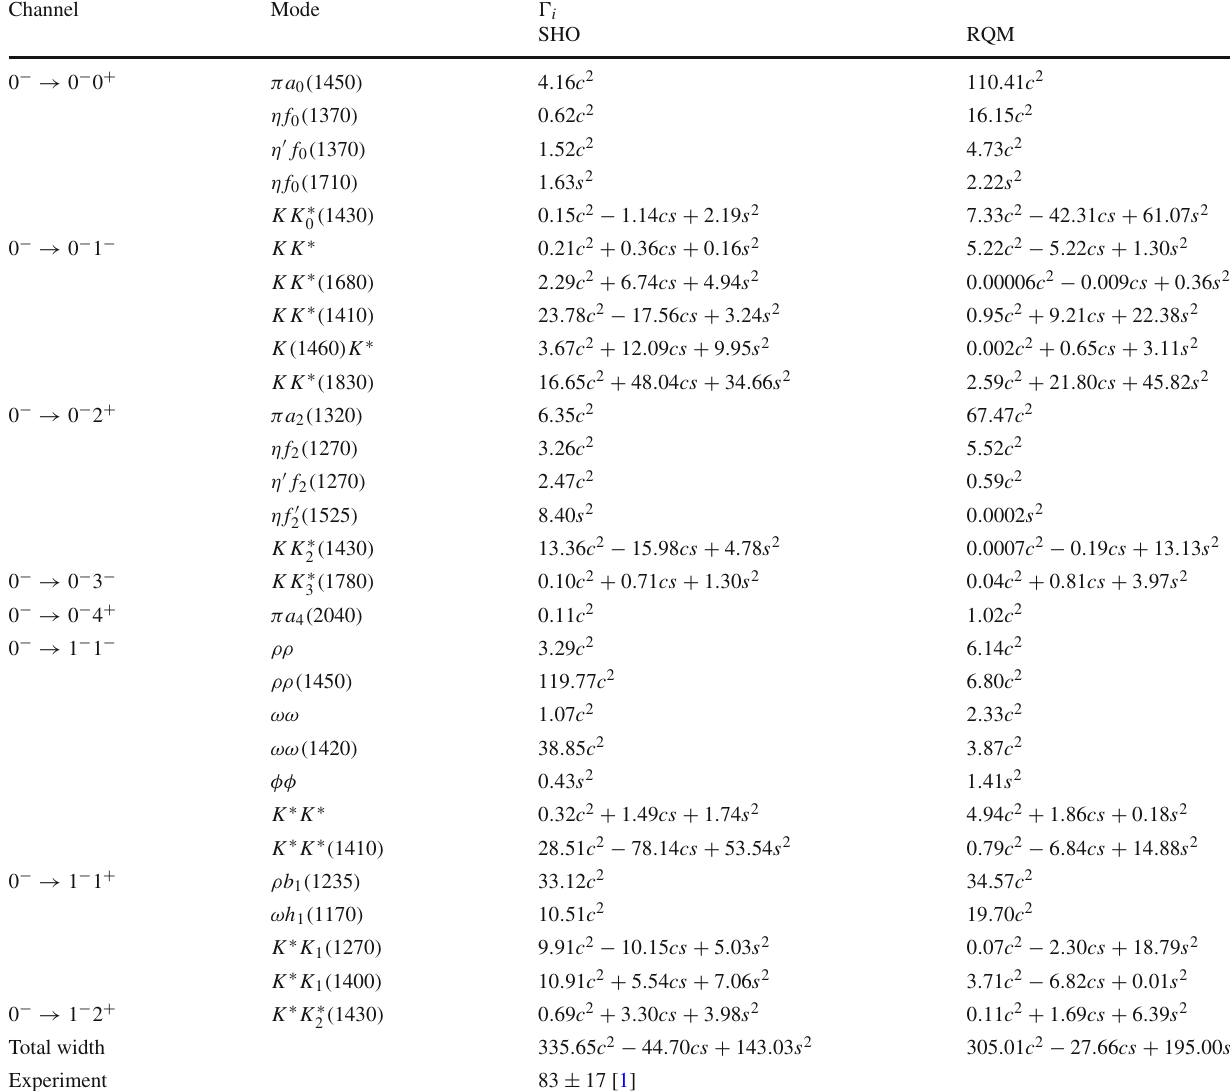
Table 5 Decay widths of the X ( 2370 ) as the 5 1 S 0 state in the 3 P 0 model with two types of wave functions (in MeV). The initial state mass is set to 2376 . 3 MeV